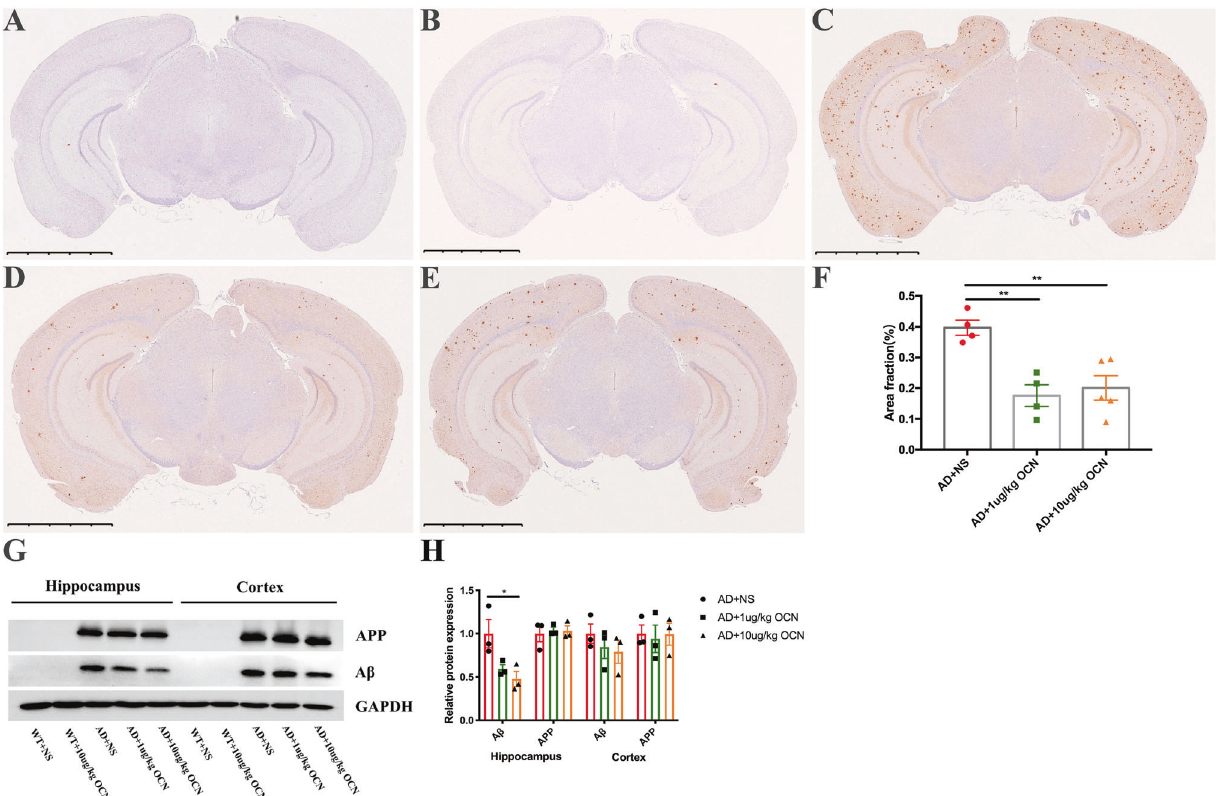
OCN inhibited the proliferation of astrocytes in the hippocampus of AD mice Mounting evidence have shown that activation of glial cells, including astrocytes and microglia, not only plays an important role in neuroin fl ammation but also is a key player in mediating A β generation, neuronal loss and brain glucose dysregulation involved in neurodegeneration [18 – 20]. Thus, we stained GFAP and Iba1-positive cells in the hippocampus of mice. A signi fi cant proliferation of astrocytes was observed in AD mice ( P =